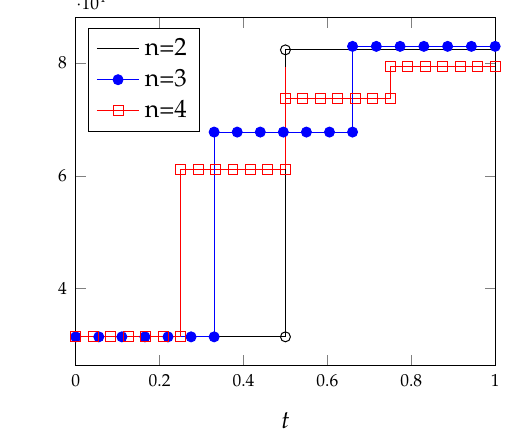
Figure 3. Optimal cumulative expense E under full liability and GL1 model.